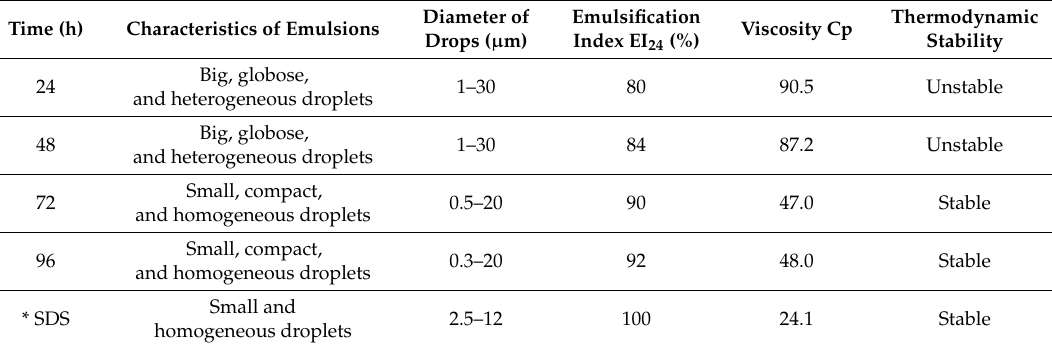
Table 4. Evaluation of the stability of the bioemulsifier after exposure to different pH, concentrations of NaCl, and temperatures by viscosity determinations.